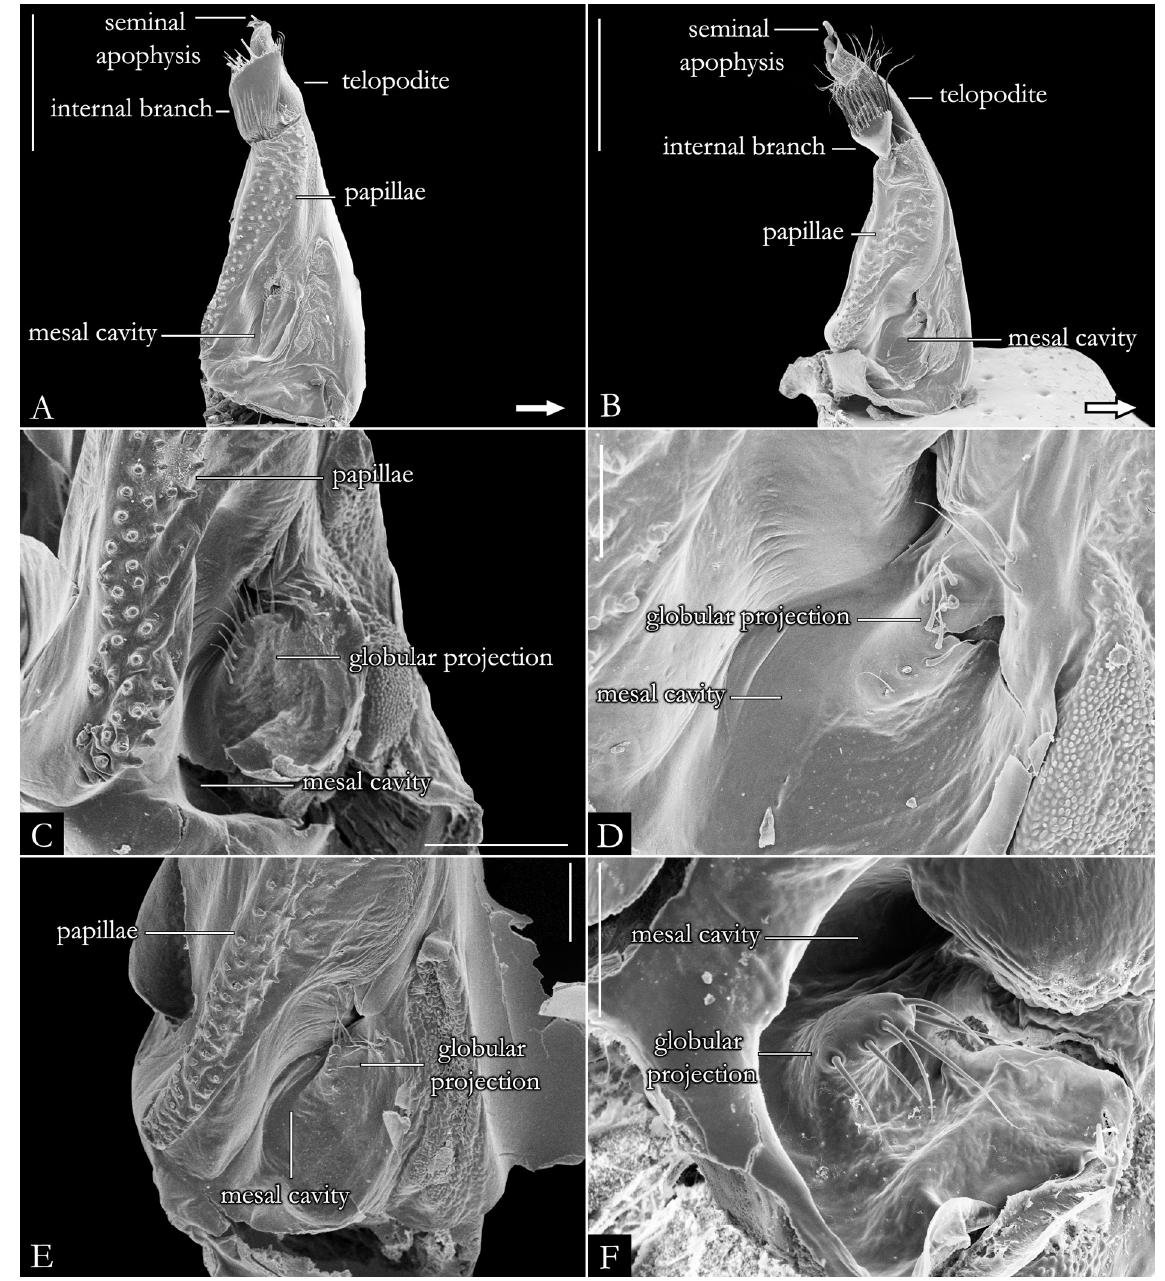
Fig. 32. SEM images of right gonopods in mesal view. A . Pseudonannolene caatinga Iniesta & Ferreira, 2014 (IBSP 2166). B . P. maritima Schubart, 1949 (IBSP 979). C . Detail of mesal cavity, P. paulista Brölemann, 1902 (IBSP 1908). D . Detail of mesal cavity, P. maritima (IBSP 979). E . Detail of mesal cavity, P. halophila Schubart, 1949 (IBSP 1091). F . Detail of mesal cavity, P. spelaea Iniesta & Ferreira, 2013 (IBSP 6071). Scale bars: A–B = 0.5 mm; C, F = 0.2 mm; D–E = 0.1